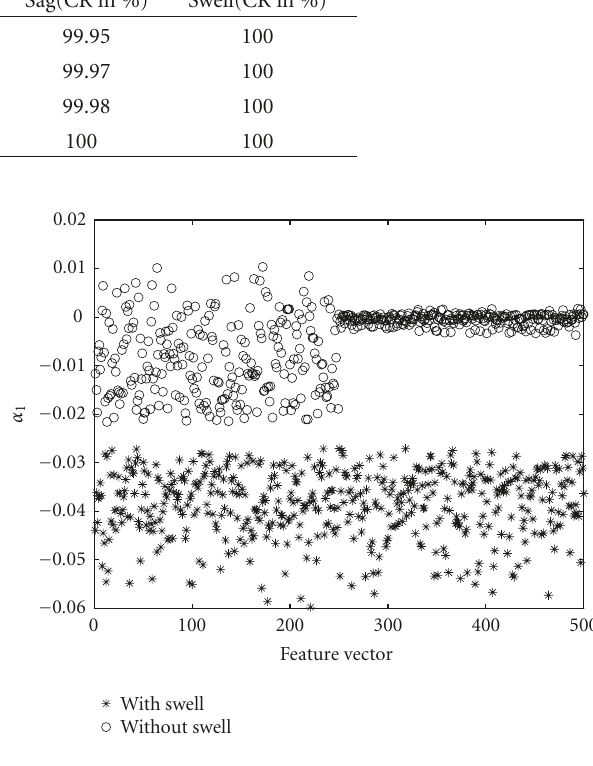
Figure 20: HOS-based features extracted from vector f for swell α = (cid:21) c 1 2, f (191).